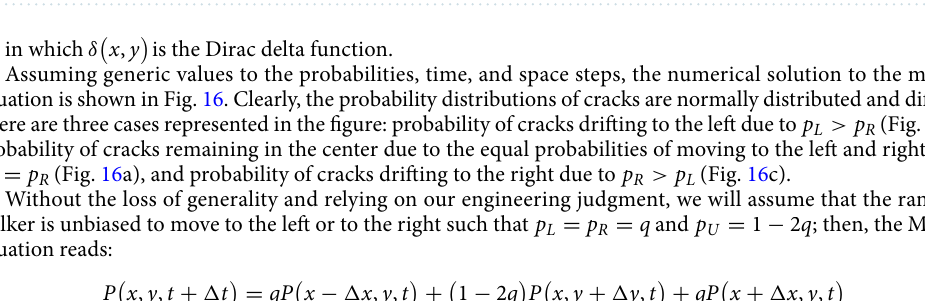
Figure 16. Solutions to the master equation of diffusion: ( a ) with left drift; ( b ) without drift; ( c ) with right